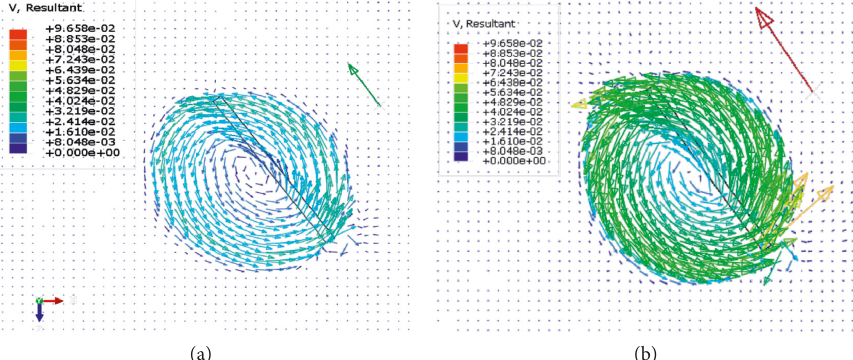
Figure 6: The soil flow around plate anchors in (a) normally consolidated soil ( Z